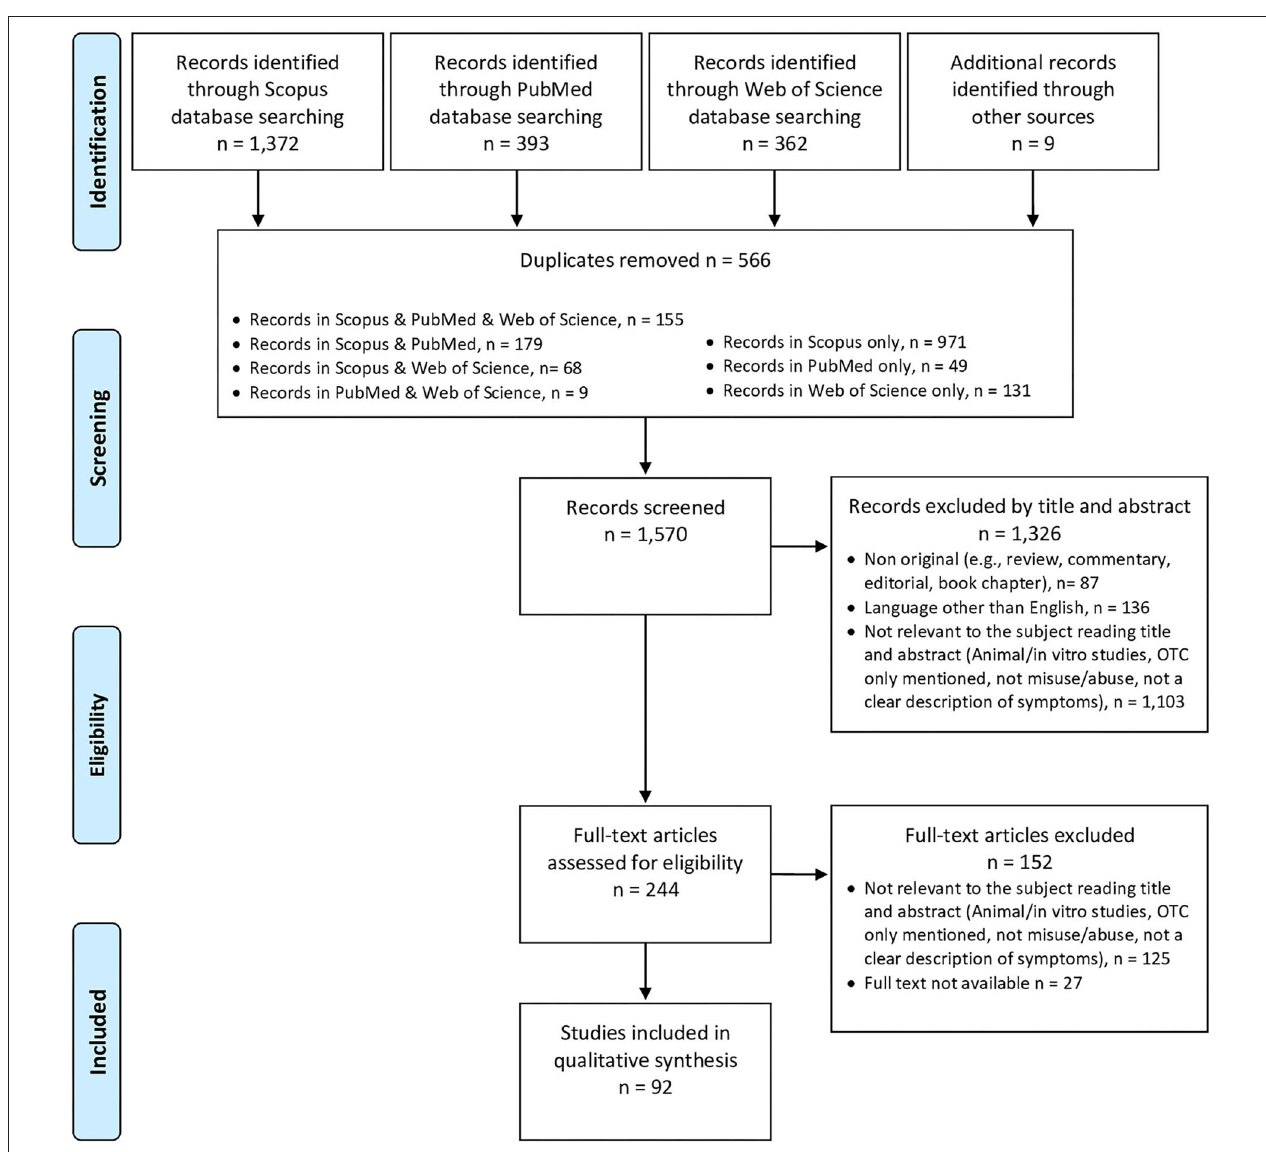
FIGURE 1 | PRISMA flow